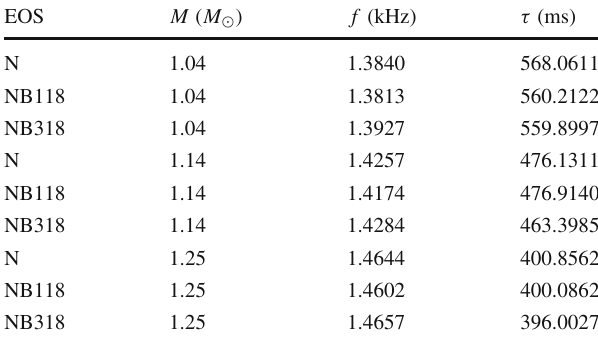
Table 6 Properties of low mass neutron stars for different values of the magnetic field EOS M ( M (cid:2)